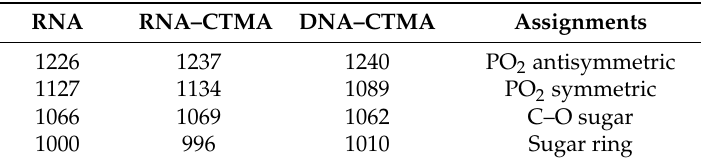
Table 1. Wavenumber of RNA, RNA–CTMA, and DNA–CTMA film. RNA